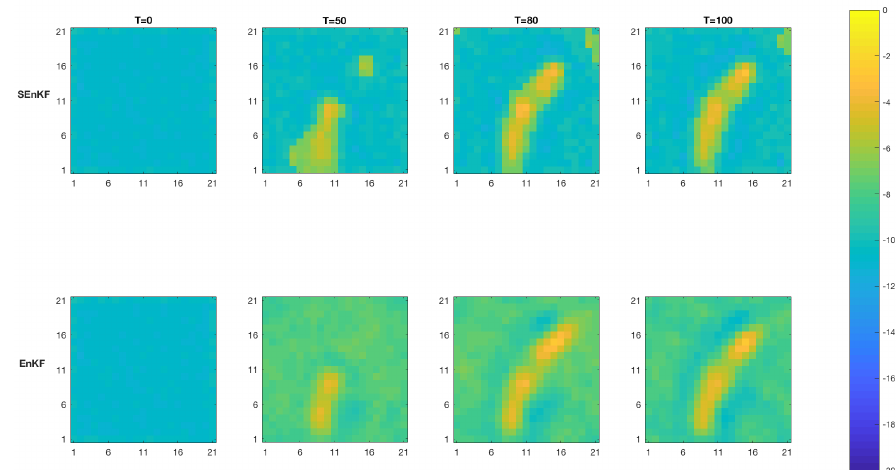
Figure 8. MMAP predictions of the log diffusivity field ( log ( λ ) | d 0: T ) at time T = 0,50,80,100 (upper panels—SEnKF approach, lower panels—EnKF approach).